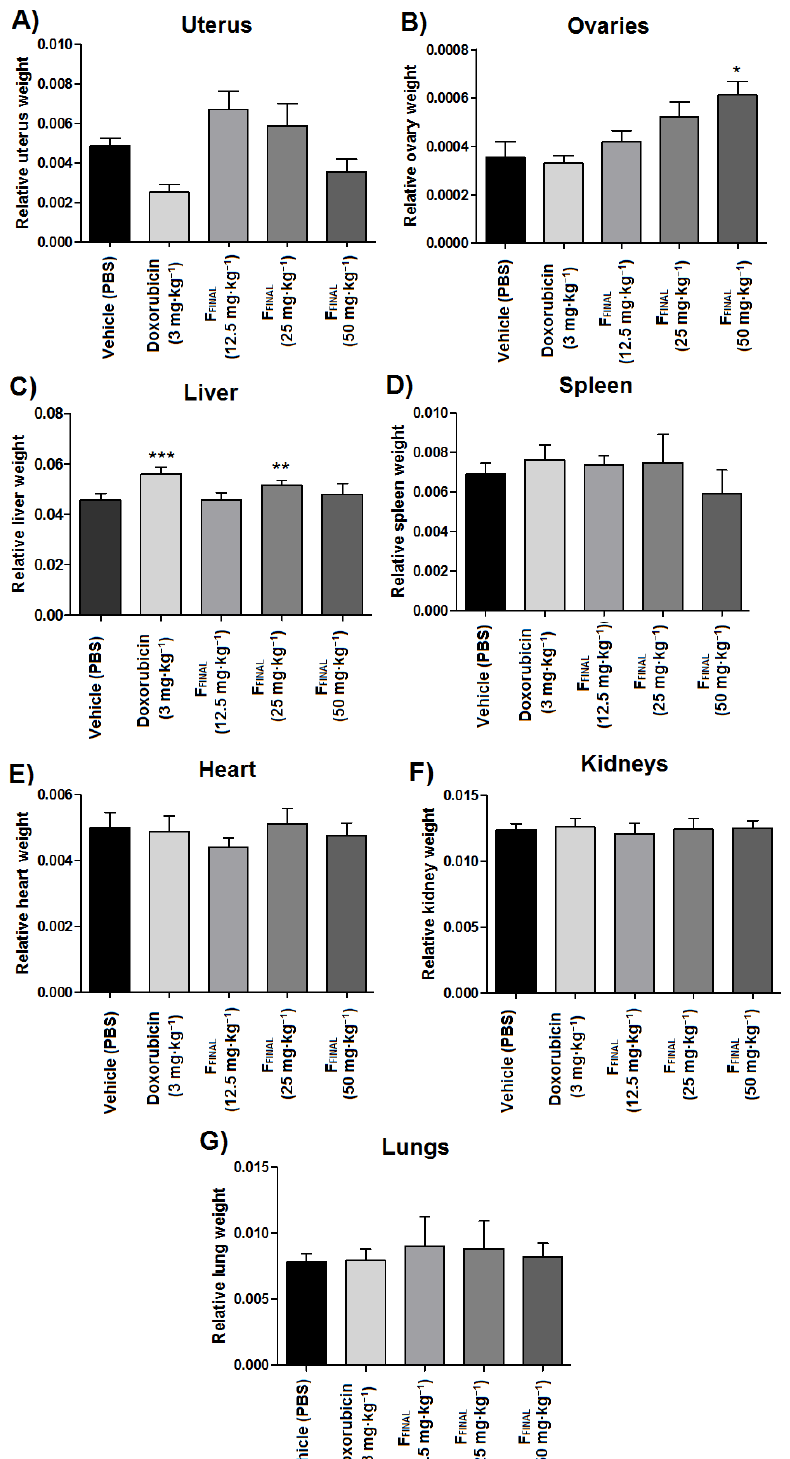
Figure 8. Relative weight of organs tested in the Ehrlich solid tumor model—F FINAL fraction. Results expressed as mean ± standard deviation; Female Balb / c mice ( n = 8 animals / group). ( A ) Uterus; ( B ) Ovaries; ( C ) Liver; ( D ) Spleen; ( E ) Heart; ( F ) Kidneys; ( G ) Lungs. Treatments (orally every day): vehicle (PBS pH 7.0 + Tween 80, 10 mL · kg − 1 ), F FINAL (12.5, 25 and 50 mg · kg − 1 ); Treatments (i.p., every three days): Doxorubicin (3 mg · kg − 1 ); * p < 0.05, ** p < 0.01 and *** p < 0.001 - di ff erent from vehicle group. Tukey test